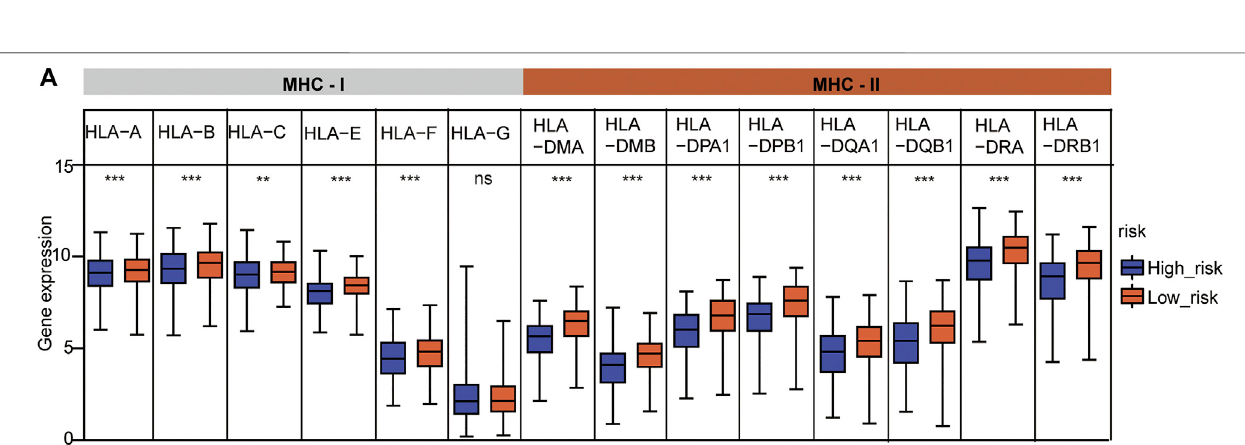
FIGURE 7 | Immune cell in fi ltration analysis of the Cox model. (A) Landscape of immune cell in fi ltration in the TME of TCGA-LUAD. (B) Comparison of immune cell in fi ltration in the TME of the two risk groups. The statistical signi fi cance was calculated via the Wilcoxon rank-sum test, * p < 0.05, ** p < 0.01, and *** p < 0.001.